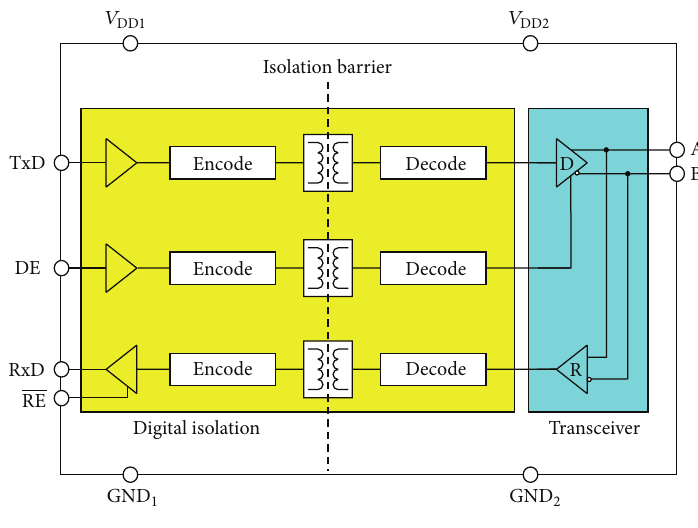
Figure 4: Block diagram of internal ADM2483.